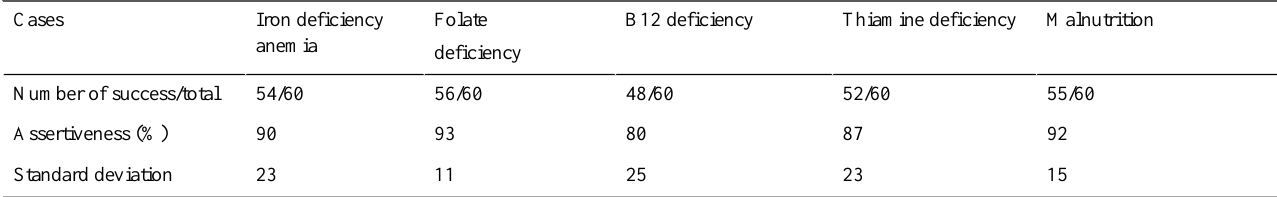
Table 1. Success rate for nutritional diagnosis between the four experts and the gold standard/ BN